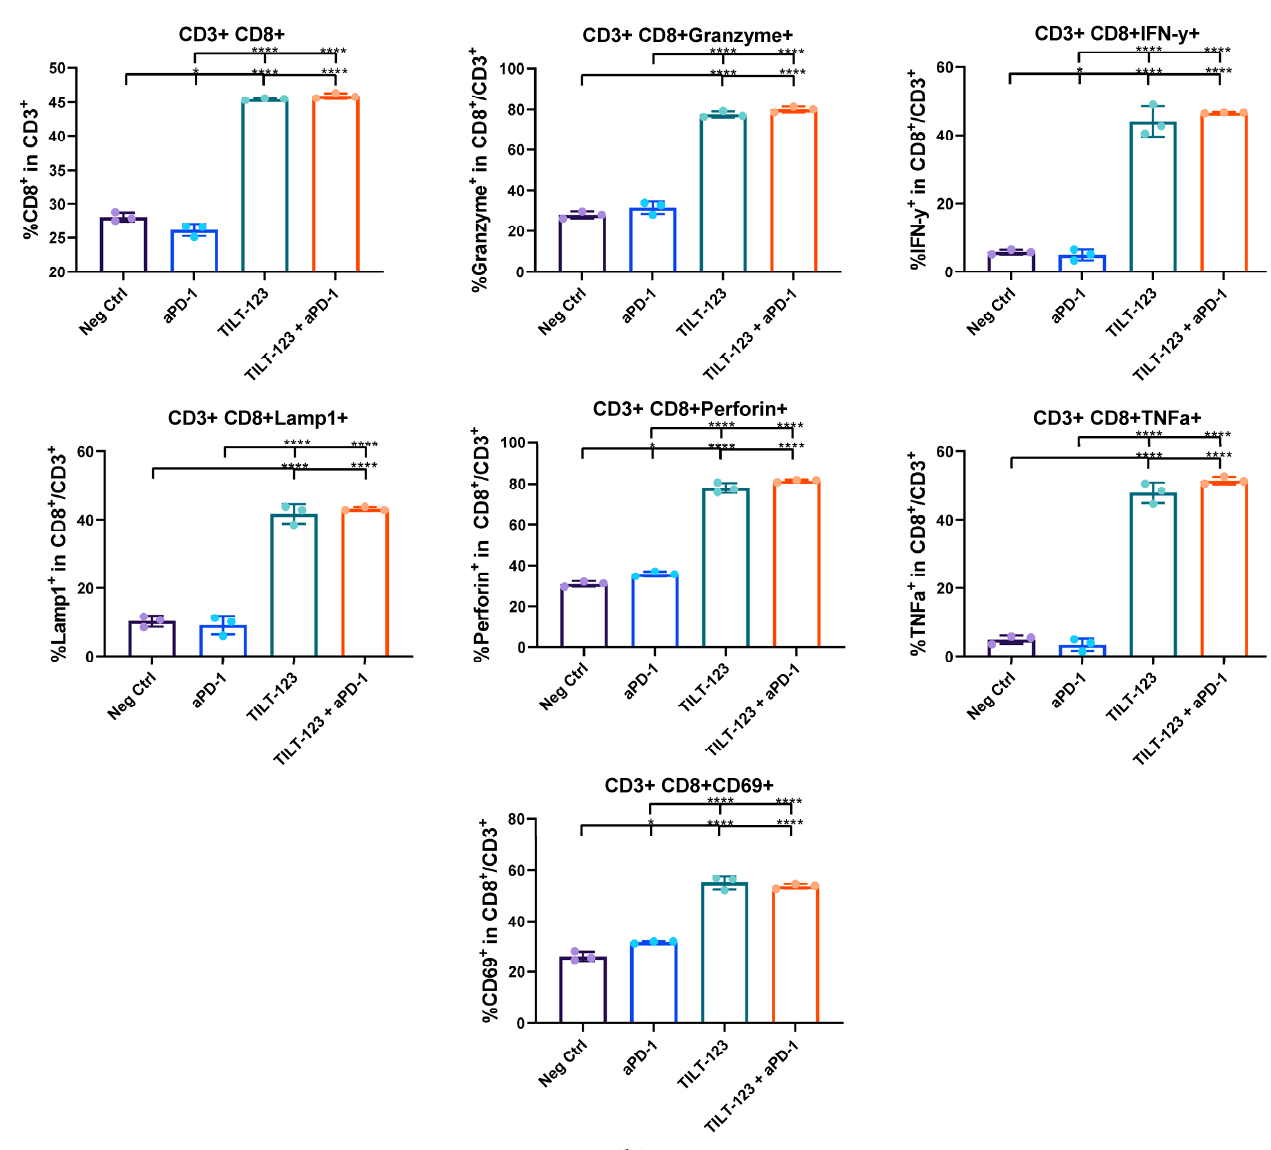
Figure 3. T cell responses to in vitro; viro- and checkpoint inhibitor therapy. T cells isolated from human patient samples were incubated in the stated settings. The response to the treatment was measured by flow cytometry of triplicates. Data for ( a ) CD4 positive cells and for ( b ) CD8 posi- tive cells.Statistics; One way ANOVA (Tukey’s multiple comparison) was used for statistics, with * p ≤ 0.05, *** p ≤ 0.001, **** p ≤ 0.0001 Combinatorial treatments halt tumor growth or cure animals bearing ovarian cancer